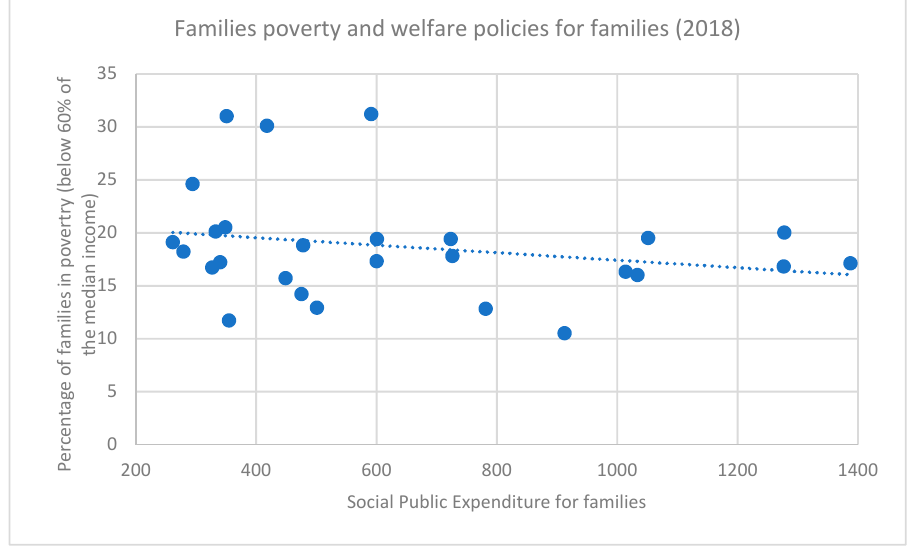
Figure 8. Source: our elaboration on Eurostat data.